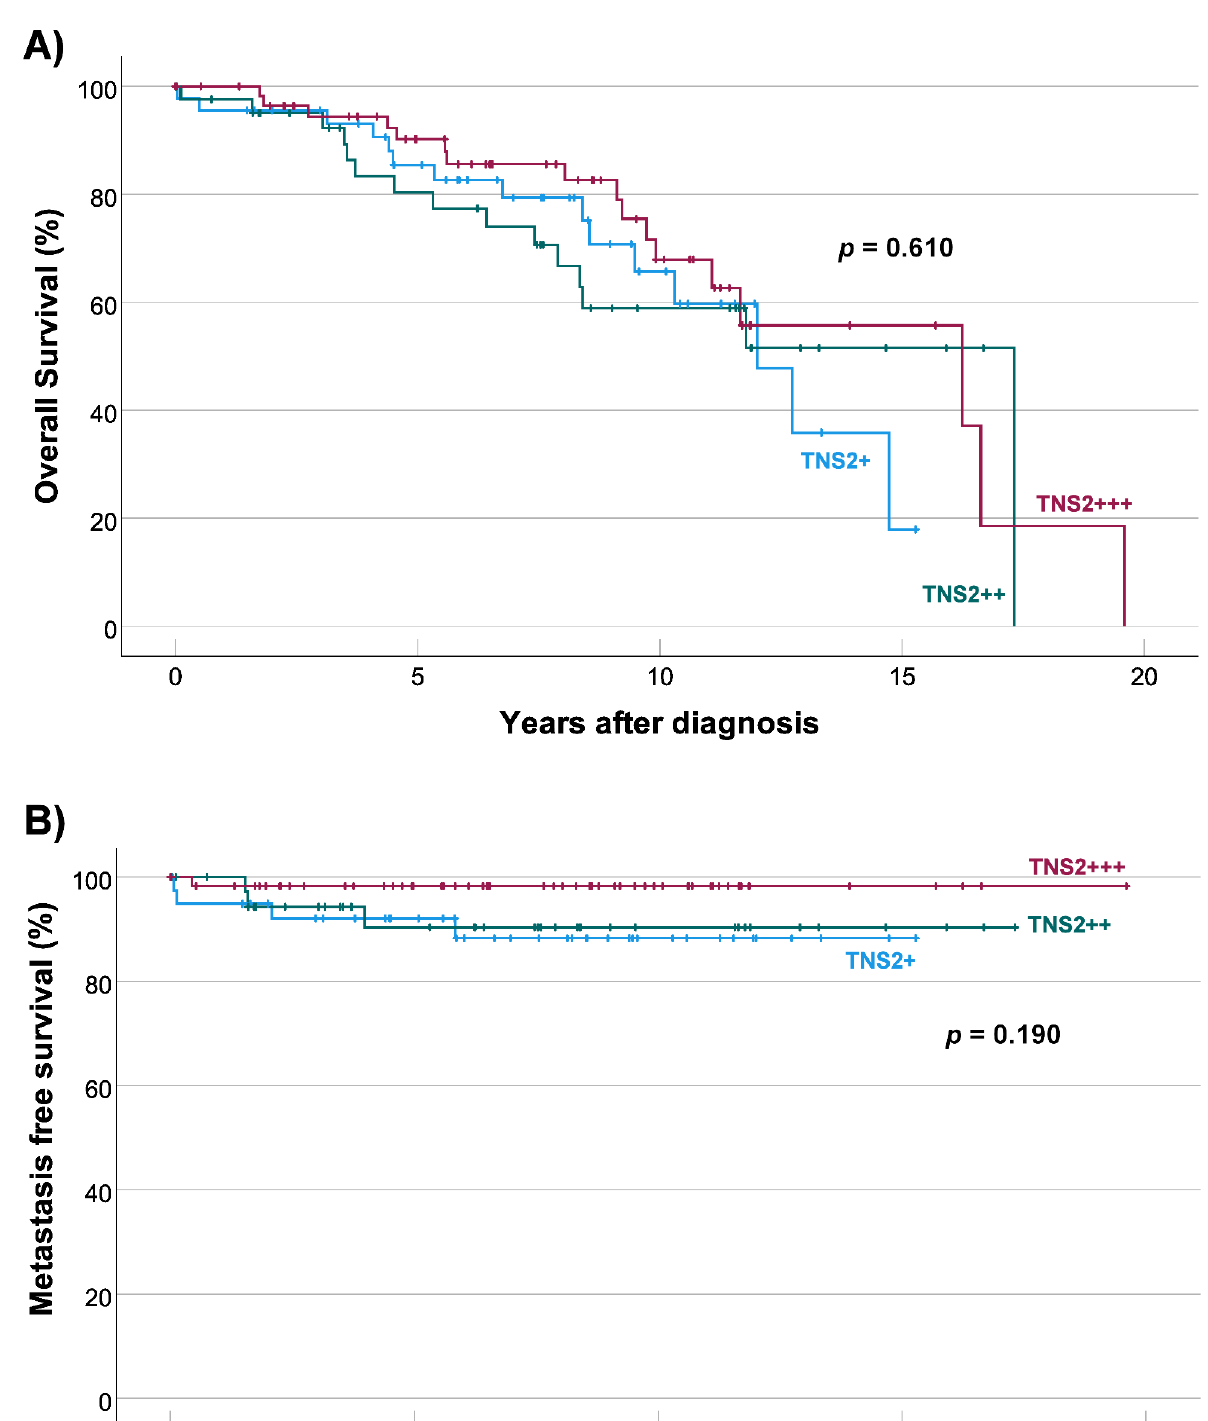
Figure 4. Kaplan–Meier analyses of overall survival ( A ) and metastasis-free survival ( B ) for patients with weak (TNS2+), intermediate (TNS2++), or strong (TNS2+++) expression. ( A ) No association was found between overall survival and TNS2 expression level ( p = 0.610, MC test). ( B ) No association was found between metastasis-free survival and TNS2 expression level ( p = 0.190, MC